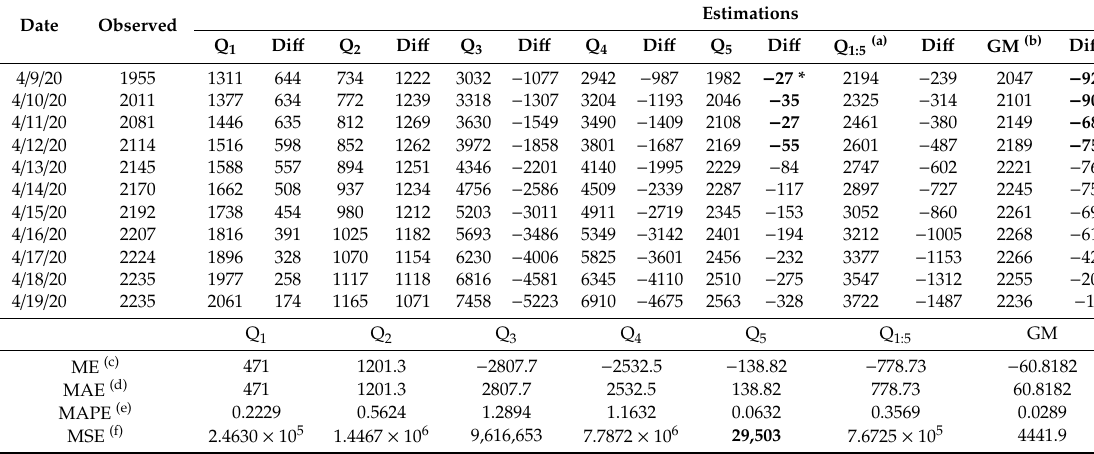
Table 1. Future cases of the COVID-19 cumulative infection curve (from 43rd to 54th day) based on the parametric fittings applied to each community ( Q 1 : Q 5 ).